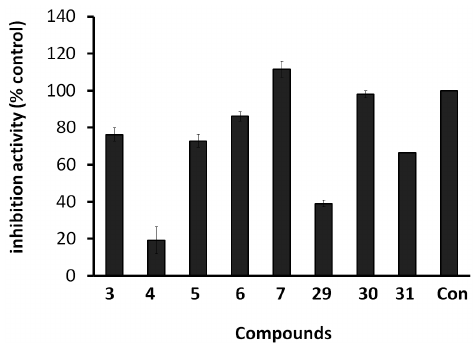
Figure 3. Inhibition activity of the bicyclo[3.1.0]hexane-based derivatives against GlfT2.